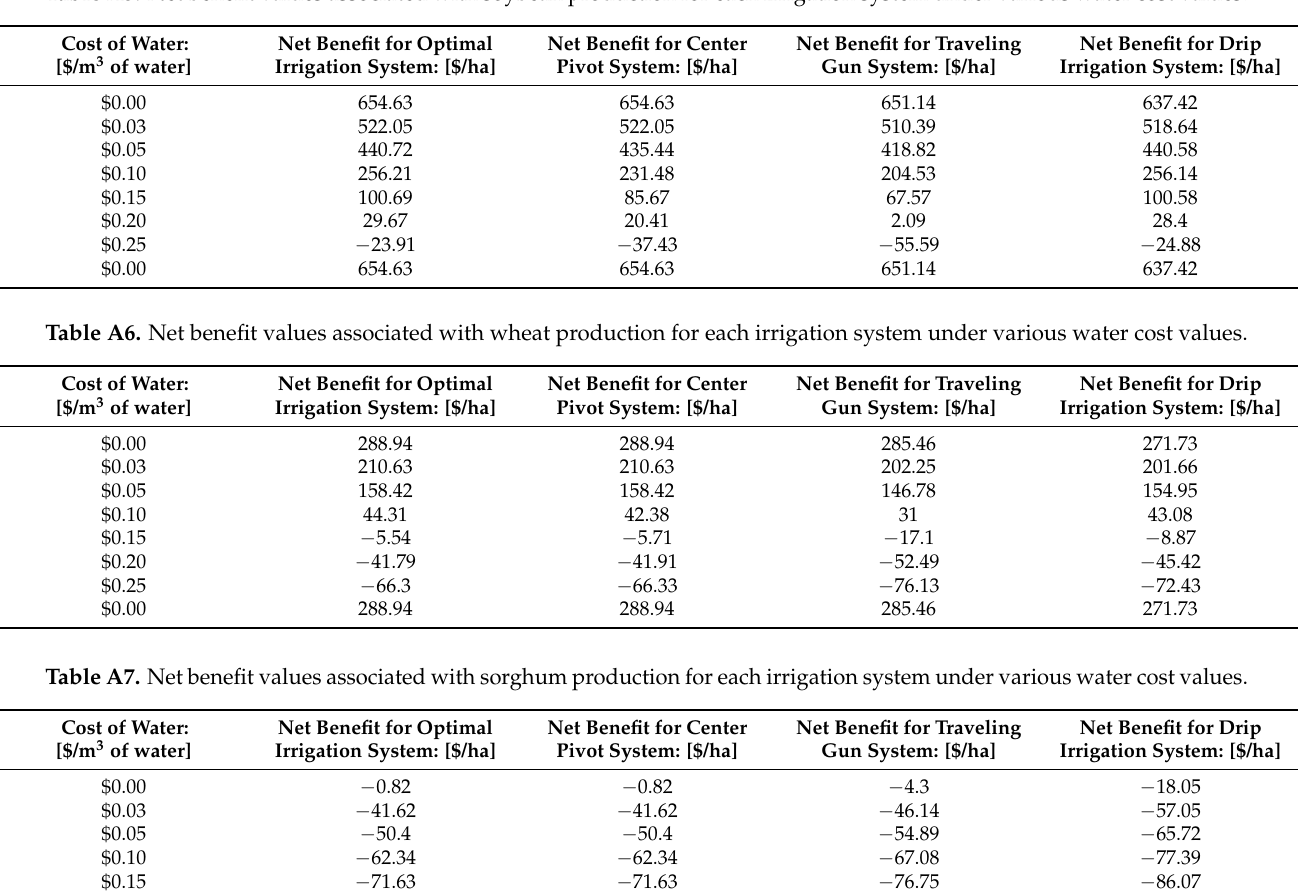
Net Benefit for Center Net Benefit for Traveling Net Benefit for Drip Pivot System: [$/ha] Gun System: [$/ha] Irrigation System: [$/ha]